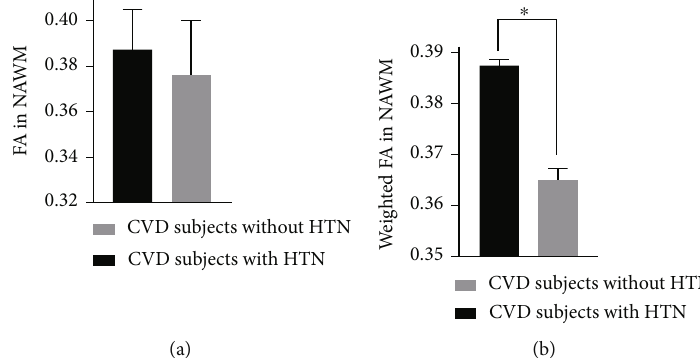
Figure 6: FA in NAWM in CVD subjects without and with hypertension (HTN) (a) and FA in NAWM weighted by the normalized WMH volumes in CVD subjects without and with HTN (b). The bars and error bars in panel (a) represent the mean and standard deviation of FA in NAWM. The bars and error bars in panel (b) represent the weighted mean and weighted standard deviation of FA in NAWM following statistical weighting by the normalized WMH volumes. Data with asterisk were signi fi cantly di ff erent as detected by ANCOVA test ( p value < 0.001).